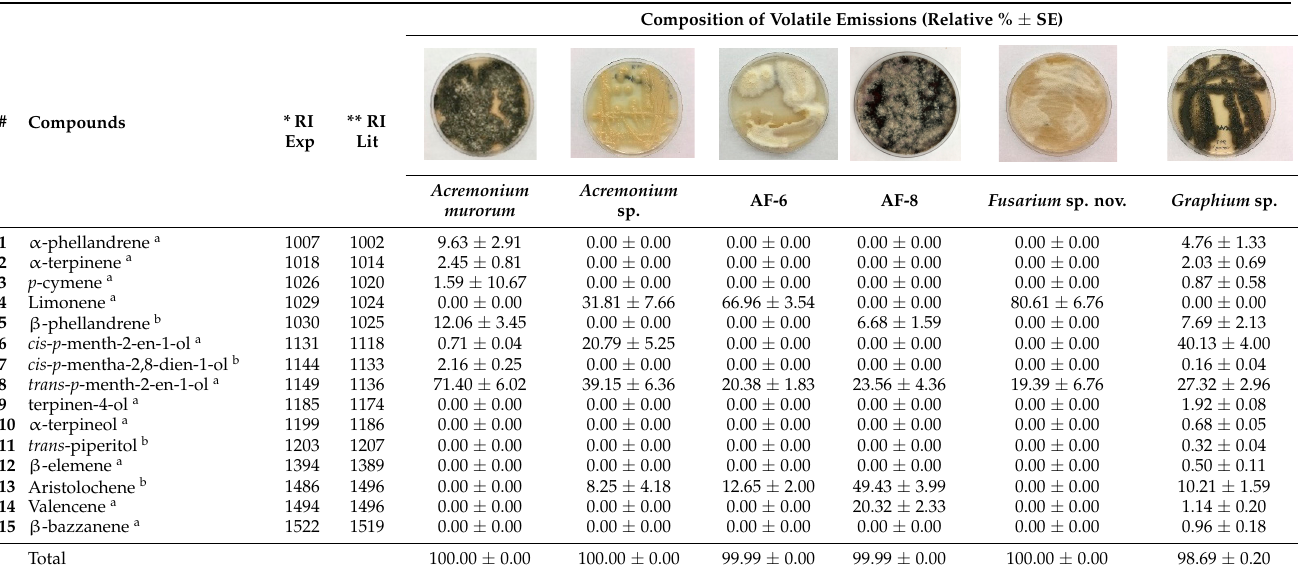
* RI exp: retention indices calculated on DB-5 column; ** RI lit: retention indices from Adams Library [22]; relative concentration was expressed as the peak area and data listed were the mean of three injection results ± standard error (SE); a compound identified using retention time of authentic stand- ard, matching with MS libraries and comparison with reported RI; b compound identified by match- ing with MS library and comparison with reported RI.